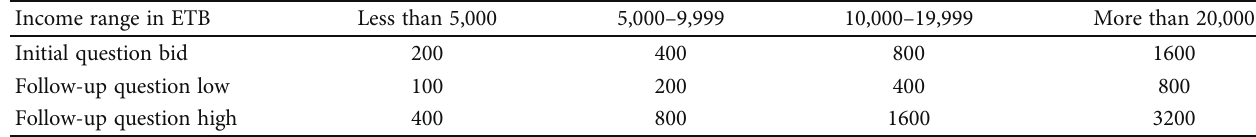
Table 2: Sets of bid information (source: authors).